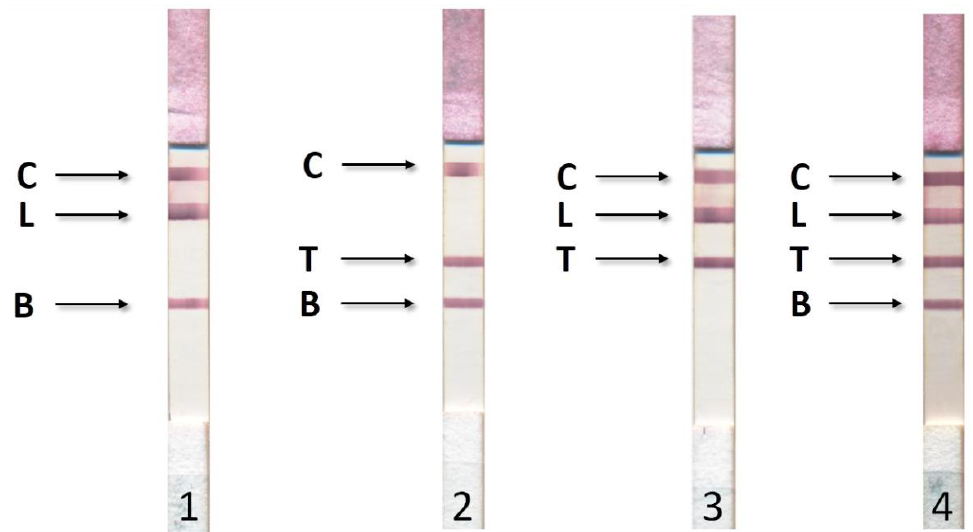
Figure 3. Examples of testing of the serum panel preliminarily characterized by ELISA using the developed multiplex immunochromatographic system.